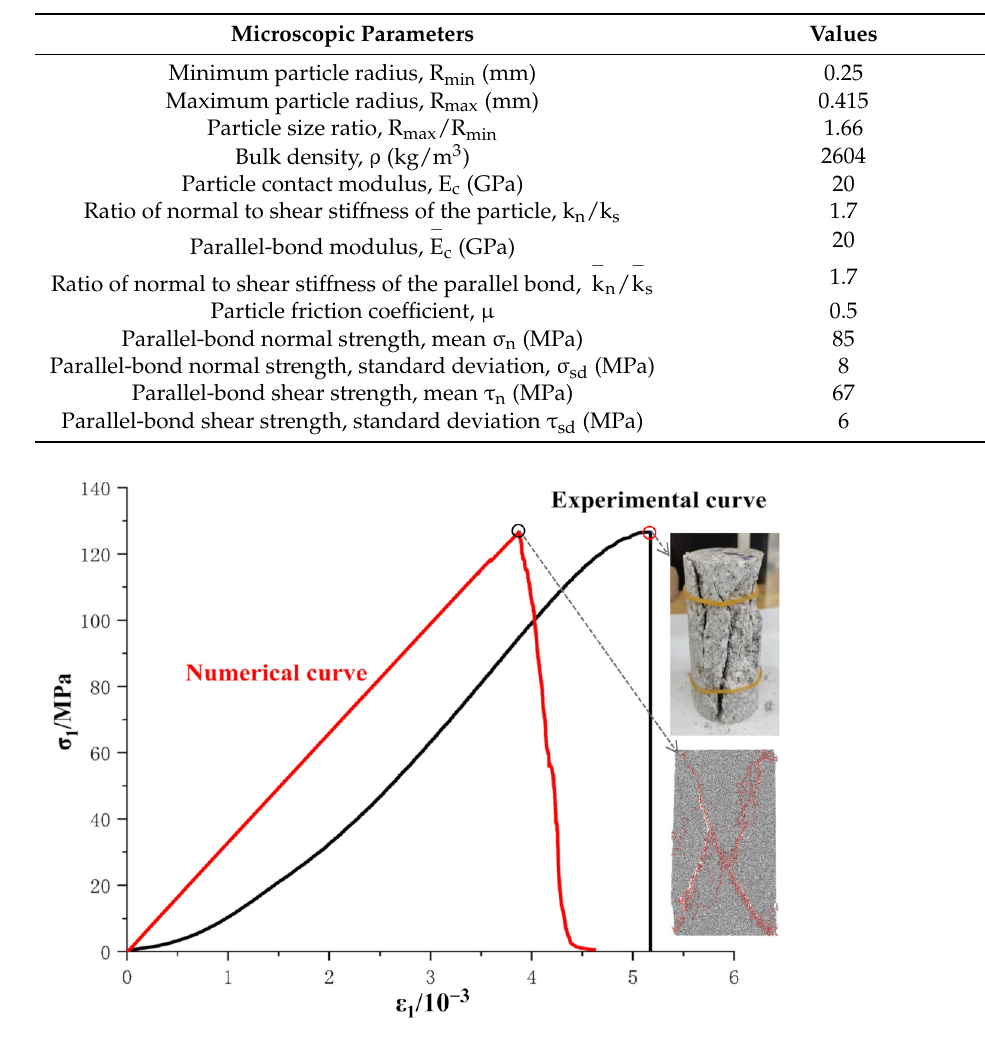
Table 1. Microscopic parameters of granite numerical specimens.